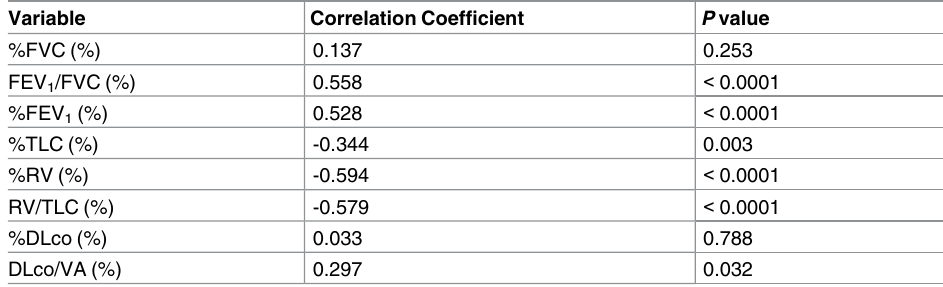
FVC: forced vital capacity, FEV 1 : forced expiratory volume in 1 s, TLC: total lung capacity, RV: residual volume, DLco: diffusion capacity for carbon monoxide, DLco/VA: diffusion capacity divided by the alveolar volume